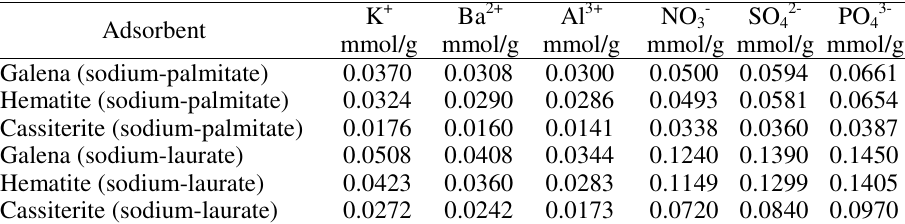
Table 1 . Adsorption capacities of sodium-palmitate and sodium-laurate at 2.0 x 10 -3 mol/L with 2.0 x 10 -5 mol/L of the added